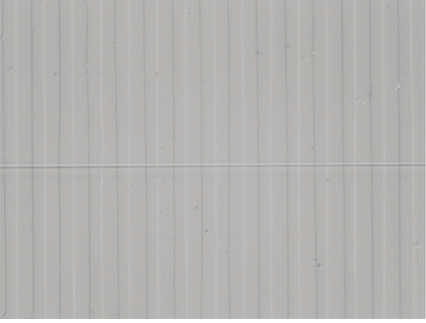
Figure 2: Periodic domain inversion structure on Ti:LiNbO 3 channel waveguide after selective chemical etching.